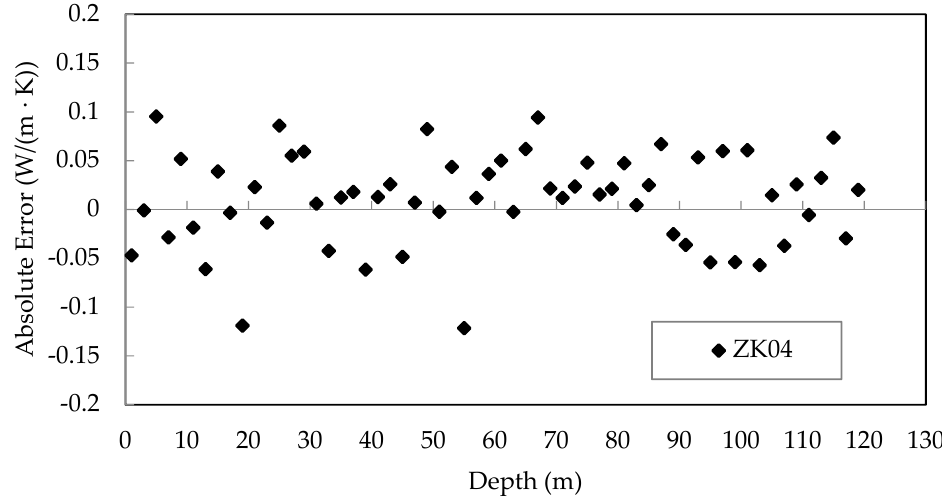
Figure 13. Absolute error of testing results of ANN models.